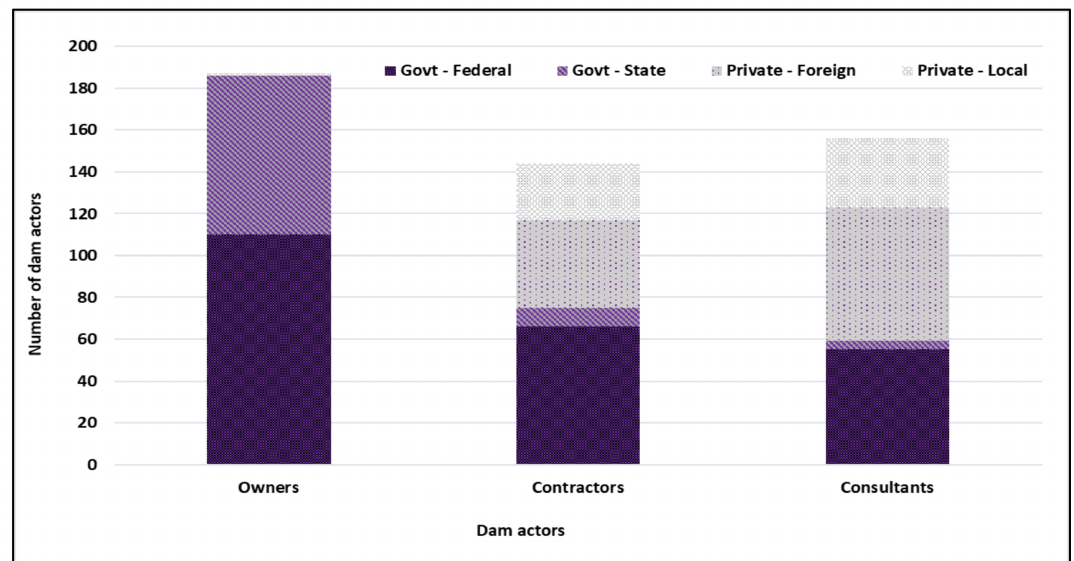
Figure 9. Dam actors: distribution of dam ownership, contractors, and consultants in Nigeria